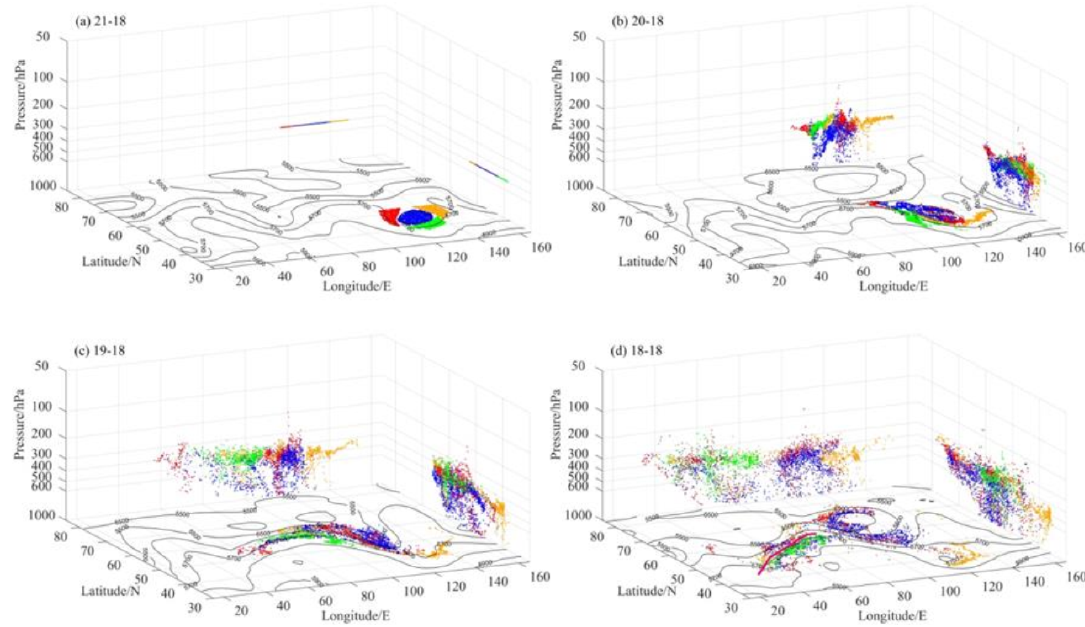
Figure 7. The initial positions of the four parts of the targeted parcels in the main body of the COL at 500 hPa ( a ). Projection of the targeted parcels on the longitude–latitude, longitude–height, and latitude–height planes at 18:00 on 20 June ( b ), at 18:00 on 19 June ( c ) and at 18:00 on 18 June ( d ). The geopotential height (black contours, unit: gpm) are additionally plotted on each longitude–latitude plane. Colored dots indicate different clusters. The superimposed pink solid line in ( d ) represents the extratropical jet stream